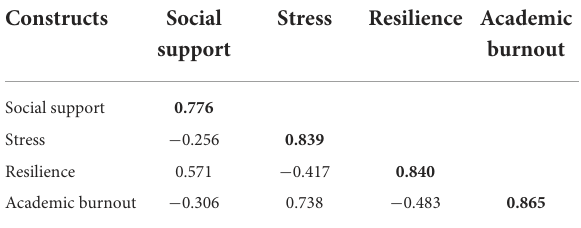
TABLE 2 Results of reliability and validity analysis. TABLE 3 Result of discriminant validity